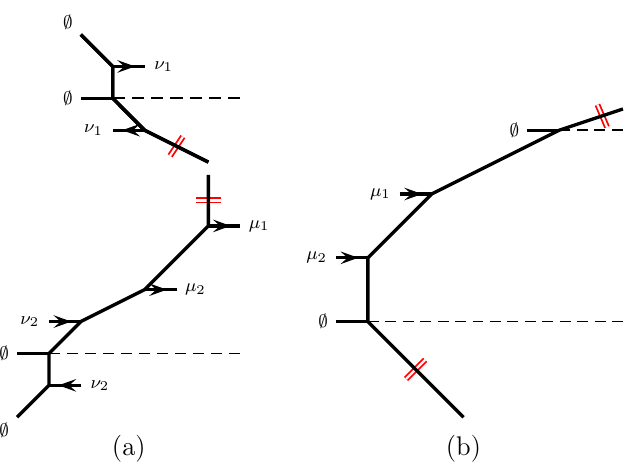
Figure 16. Strip diagrams for 5-brane webs for SU(3) theory with Z 2 twist given in figure 15. The left part (a) and the right part (b) of the web diagram in figure 15. Z left is based on (a) and Z right is based on (b). The edges denoted with || are